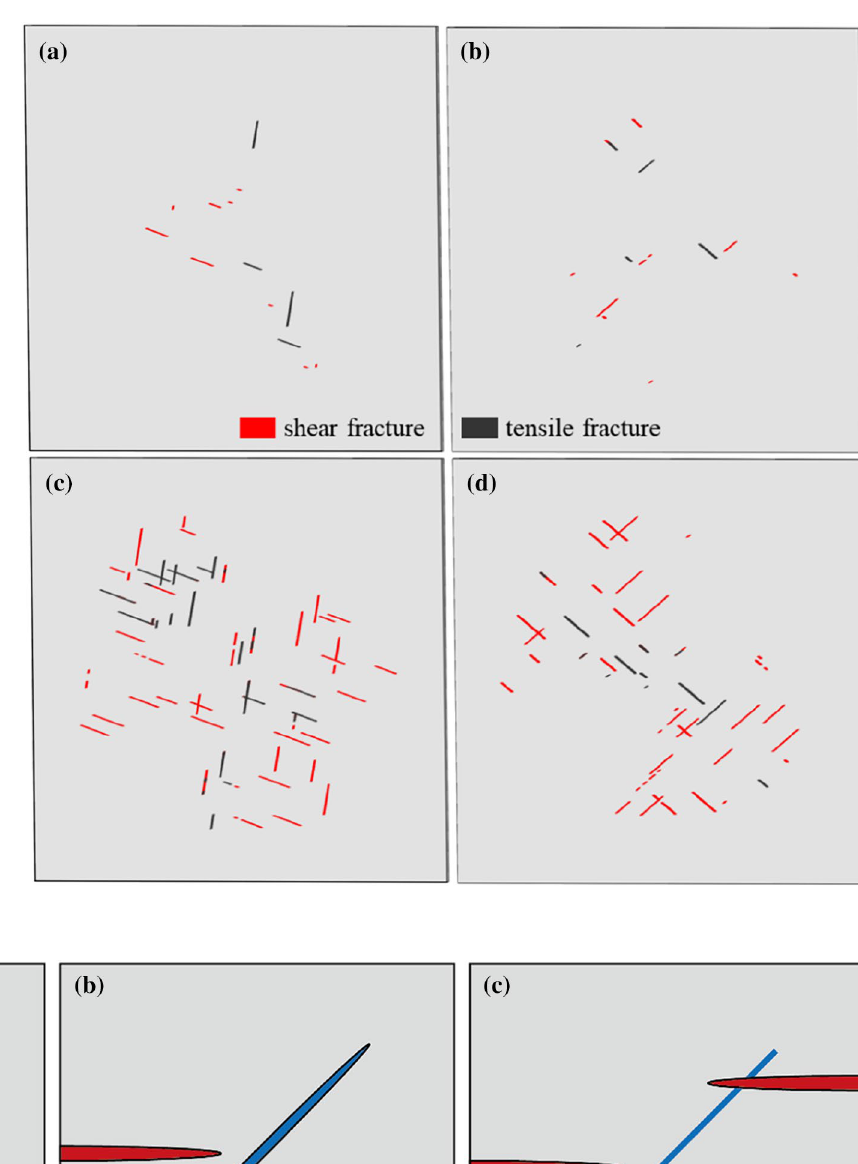
Fig. 7 Fracturing induced natu-